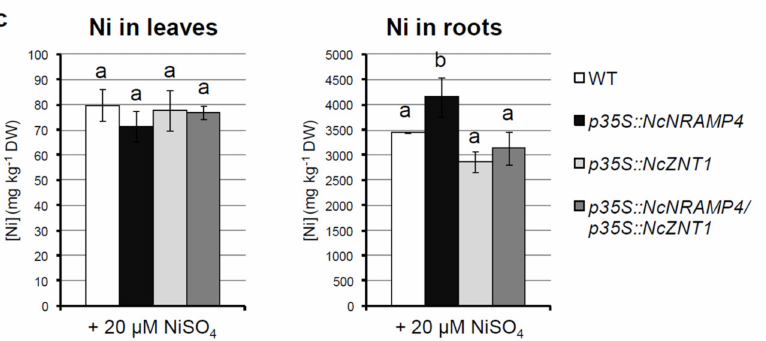
Figure 4. Metal accumulation in Arabidopsis thaliana Col_0 plants overexpressing NcNRAMP4 and NcZNT1. For metal quantification in roots and shoots—( a ) Fe, ( b ) Mn, and ( c ) Ni—plants were grown in hydroponic solution, as described in M&M, under control conditions or treated with 20 µ M NiSO 4 for two weeks. Leaves and roots for each line were collected separately in triplicate, ground to fine powder in liquid nitrogen and concentrations of Ni, Fe, and Mn were determined by ICP-AES. Statistical analyses were performed by two-way ANOVA ( n = 6) followed by a post-hoc Bonferroni test. Statistically significant variations, at p < 0.05, are marked by different letters.